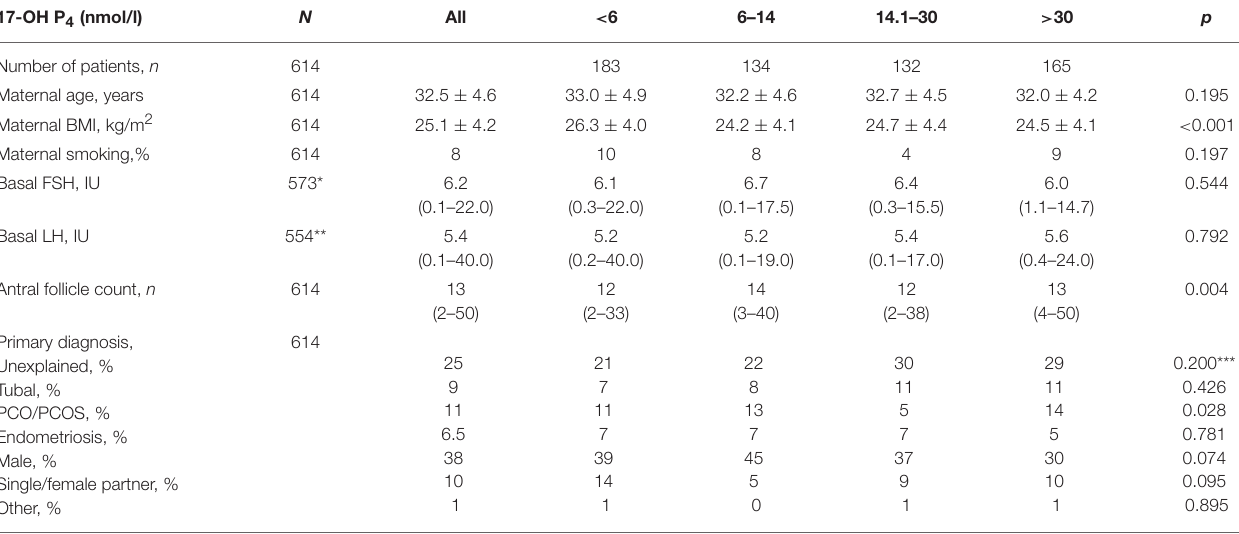
TABLE 1 | Baseline characteristics of study patients in different 17-OH P 4 groups. 17-OH P 4